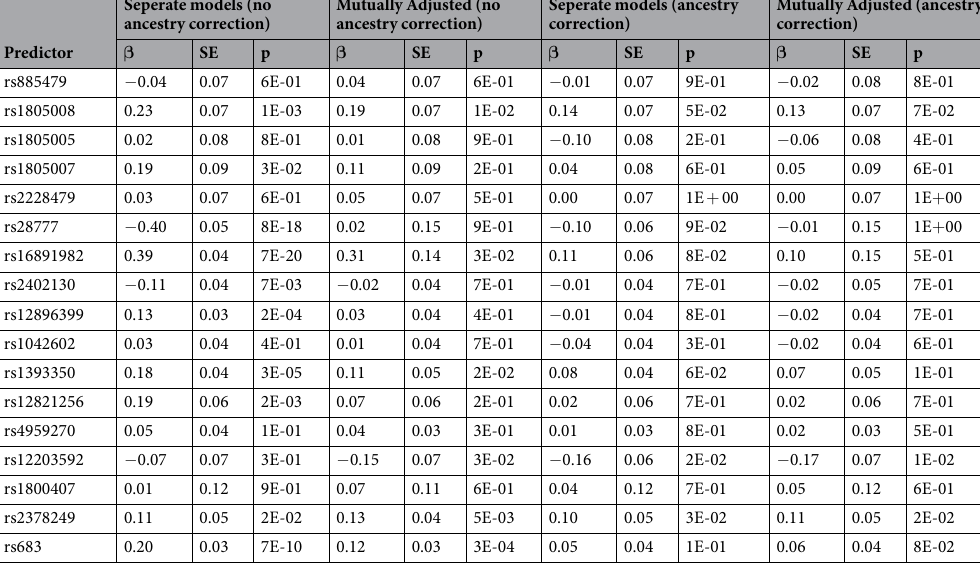
Table 3. Hair cortisol regressed on individual pigmentation SNPs in multi-ancestry sample (n = 1674). SNPs were either included in separate models or mutually adjusted in a single model. Positive coefficients indicate increases in hormone concentrations per effect allele (see Table S1,